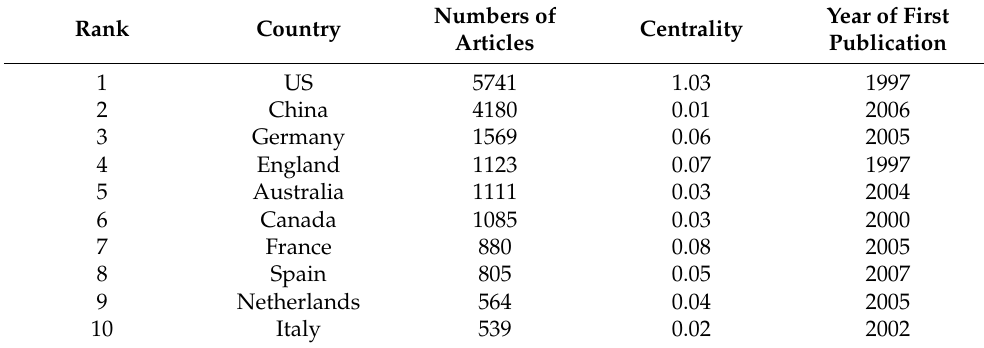
Table 4. List of contributing countries and number of records contributed.